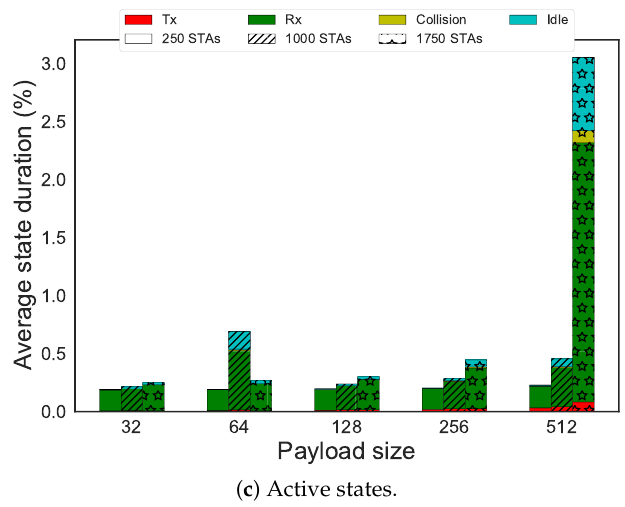
Figure 15. Energy efficiency and latency comparing different payload sizes, using 2048 ms beacon interval, average packet arrival interval of 30 s, 10 RAW groups and five slots per group.